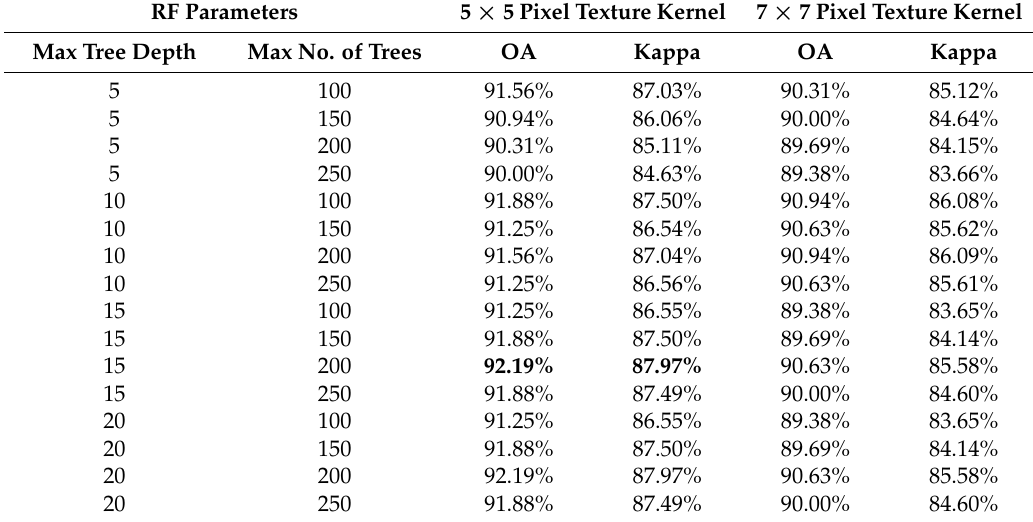
Table 2. Automated classification performance for above-water features across all five study sites under varying random forest (RF) parameter values and texture kernel sizes, with the top classification bolded . OA = overall accuracy.